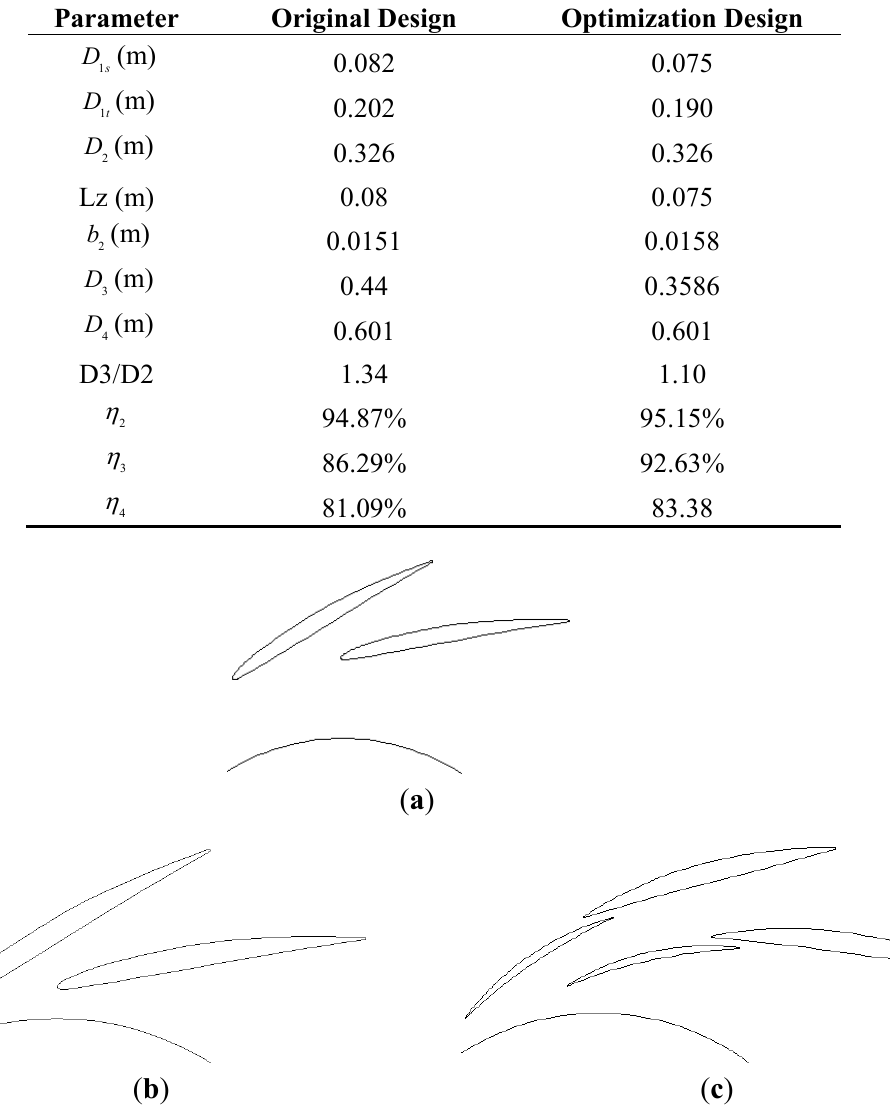
Figure 7. Geometric structure of the vaned diffuser: ( a ) Original design; ( b ) Optimization design 1; ( c ) Optimization design